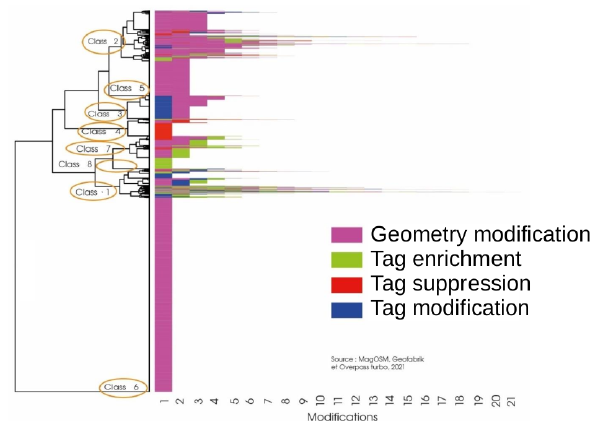
Figure 4. Carpet of sequences for the ”buildings dataset”, with a typology of four modifications.